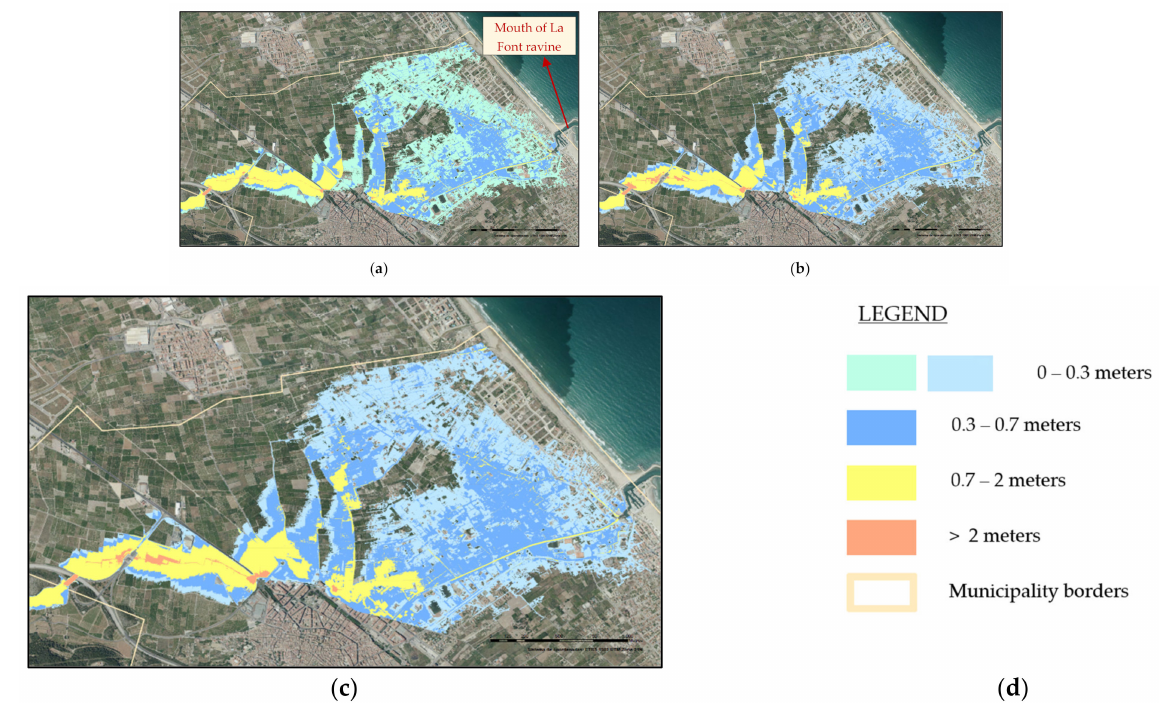
Figure 11. Hydraulic model results. Maximum depths reached for different return periods: ( a ) 25 years; ( b ) 100 years; ( c ) 500 years; ( d ) relationship between colors and depths values. All maps are oriented to the